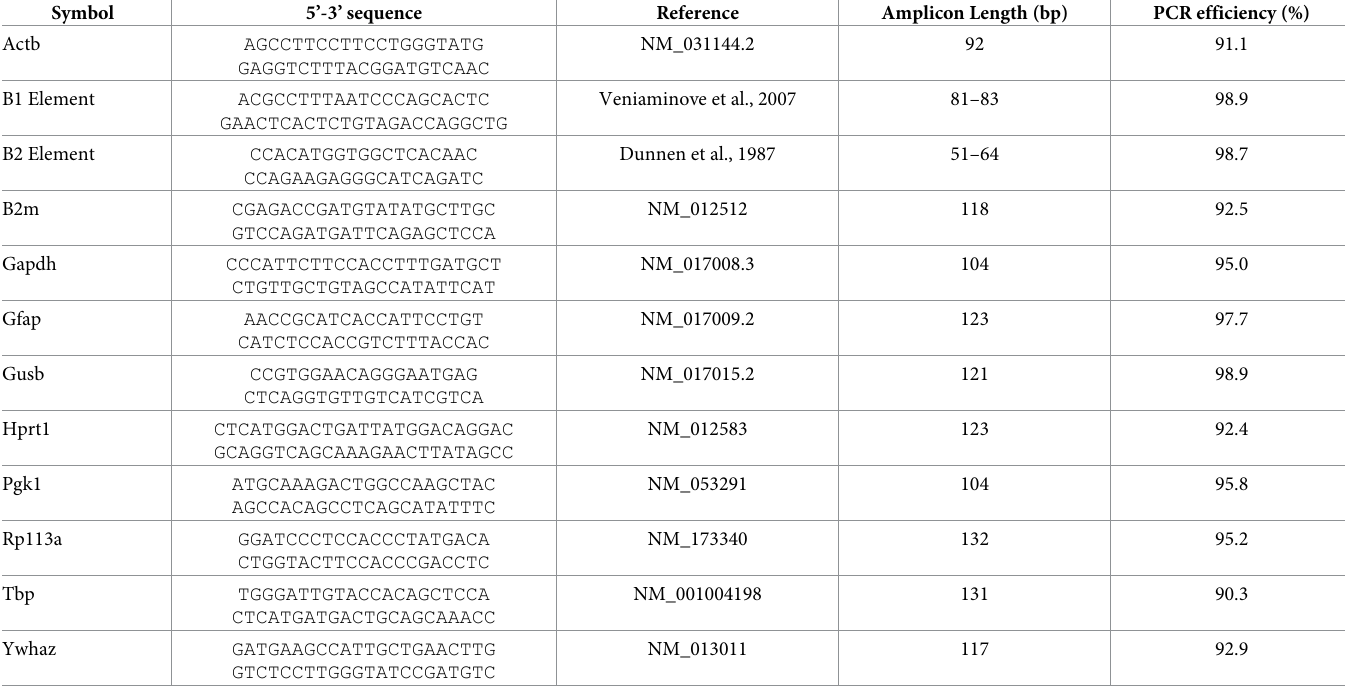
based approach by comparing the overall gene expression variation and the gene variation between sample subgroups. This results in a stability value and ranks the genes based on their stable expression. The Cq values used in both algorithms were efficiency adjusted. All the ranked gene lists obtained by the geNorm and NormFinder analyses were used in the rank aggregation R package called “RankAggreg” [34]. The weighted rank aggregation was applied to determine the most stable reference genes across the different disease stages, brain regions and algorithms. Thereby, we used the Cross-Entropy (CE) Monte Carlo algorithm, Table 2. Primer sequences and amplicon characteristics for the Rattus norvegicus used in the study.